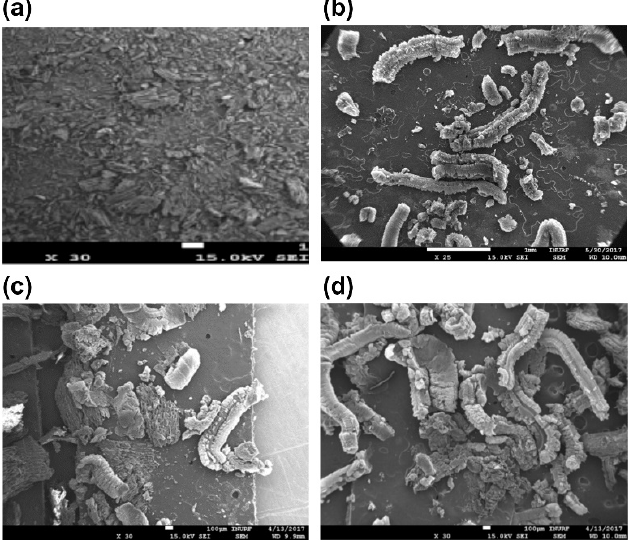
Figure 18. Fine image changes with expanded graphite wt.%: ( a ) 0, ( b ) 10, ( c ) 30, and ( d ) 50 (at 30× magnification).